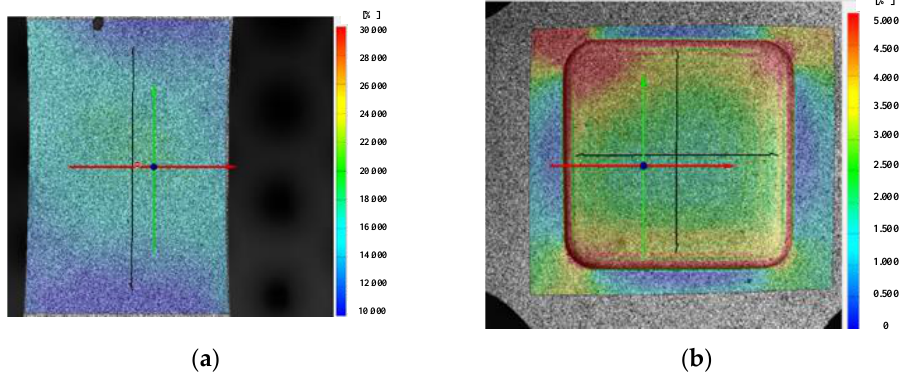
Figure 15. Uniaxial and biaxial specimens used for the test. ( a ) Uniaxial specimens; ( b ) cruciform specimens (displacement ratio (X/Y): 4:3).